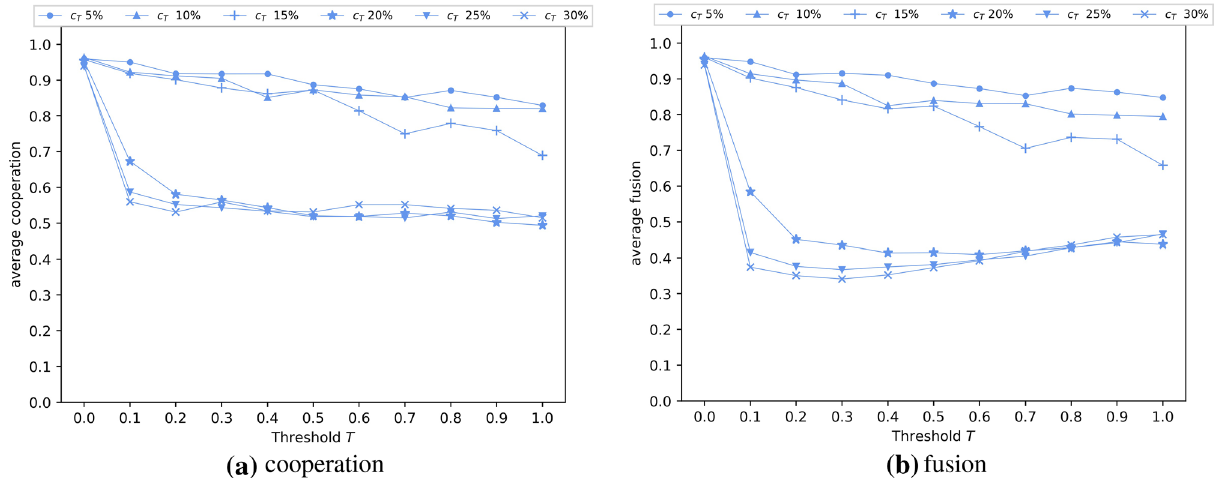
Figure 6. Average cooperation ( a ) and fusion ( b ) as a function of the cost threshold T and for different rates of the additional cost c T . Ostracism of type 3 is performed by each agent i with a probability equal to the agent’s fusion level f i . Threshold T defined as the minimum threshold that an agent’s fusion must reach ( f i ≥ T ) in order for ostracism to take place. Agents with a fusion level equal or below T incur a cost c = 0.7 for a donation while agents with fusion levels above T incur a cost of c + c T for each donation. c T is defined in a range between 5% and 30% of c . Agents interact randomly with the other fused individuals within their in-group with a probability equal to their own fusion levels ( S i = f i ). The in-group of an agent i is defined as the subset of agents having at least same level of fusion as i (i.e., f i or greater). Agents interact randomly with the whole population with a probability equal to 1 − S i . Results are averaged over five randomly seeded runs, each conducted for 50,000 generations. Parameter settings are consistent with Fig.